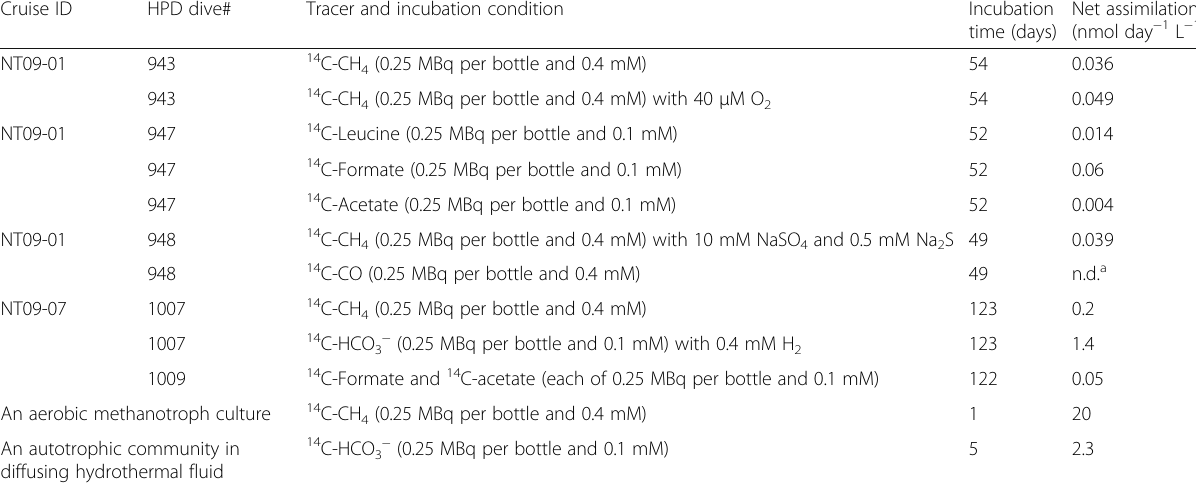
Table 3 Radio-isotope-tracer carbon assimilation of microbial community in the CORK fluids and positive controls Cruise